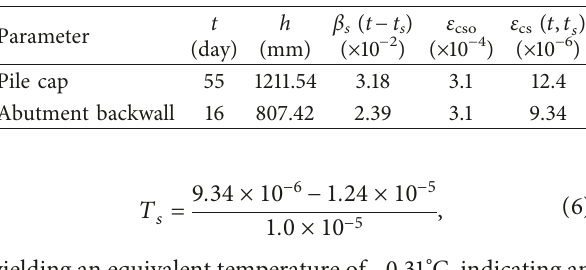
Table 4: Concrete shrinkage parameters and strain.